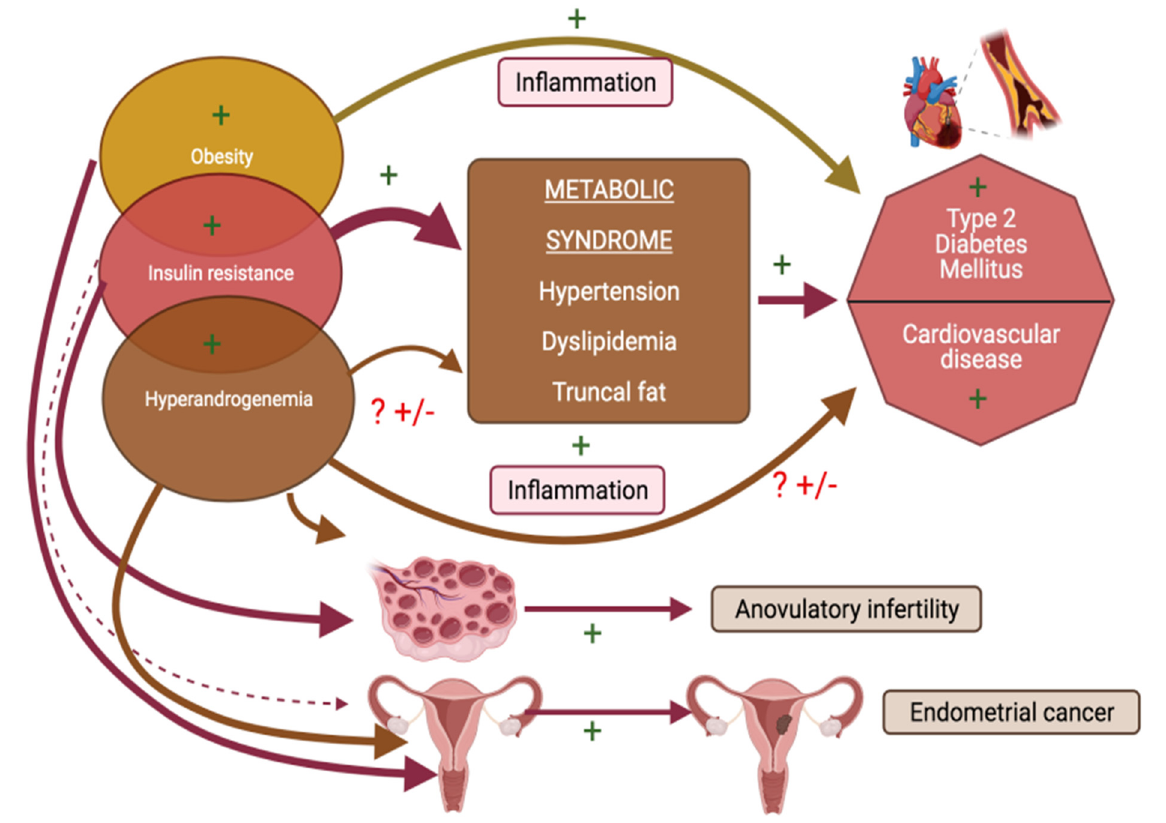
Figure 5. Schema outlining pathophysiology of polycystic ovarian syndrome (PCOS) related health burdens and targets for facilitatory effects of vitamin D (indicated by +).